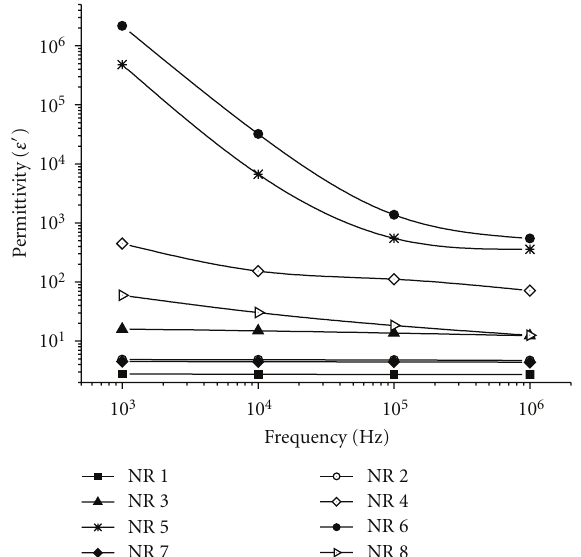
Figure 4: Frequency dependence of the dielectric permittivity ( ε (cid:3) ) for composites comprising di ff erent amounts of Printex XE-2B or Corax N220 at 80 ◦ C.